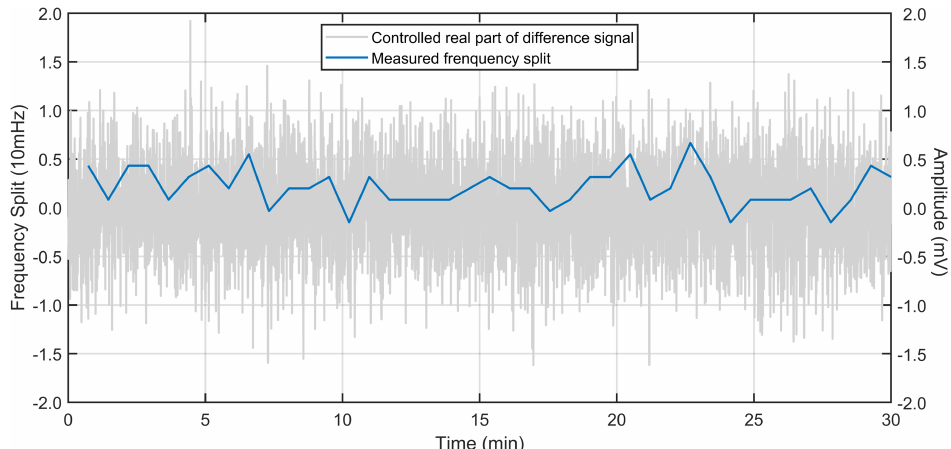
Figure 12. The in-run calibration of frequency split under dual-mode